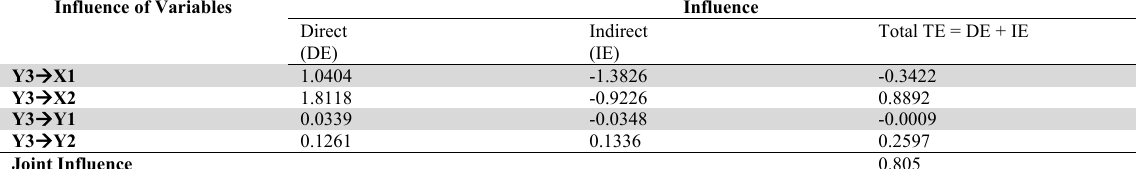
The results of direct and indirect effects